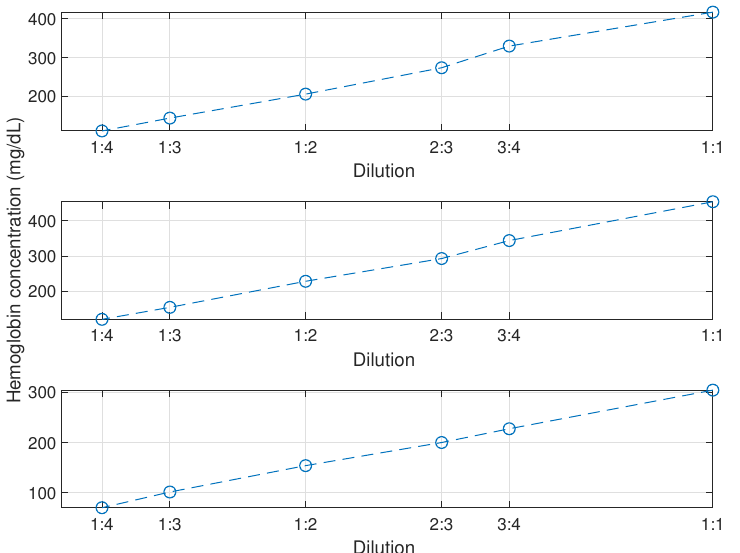
Figure 9. Hemoglobin concentration of dilution specimen for Sub-bags 4, 5 and 6 (from up to down) on the last day of test with the spectrophotometer.